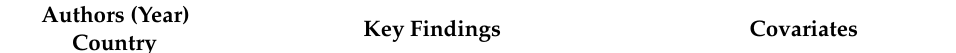
Table 3. Summary of key findings on the relationship between caregiver–child attachment and